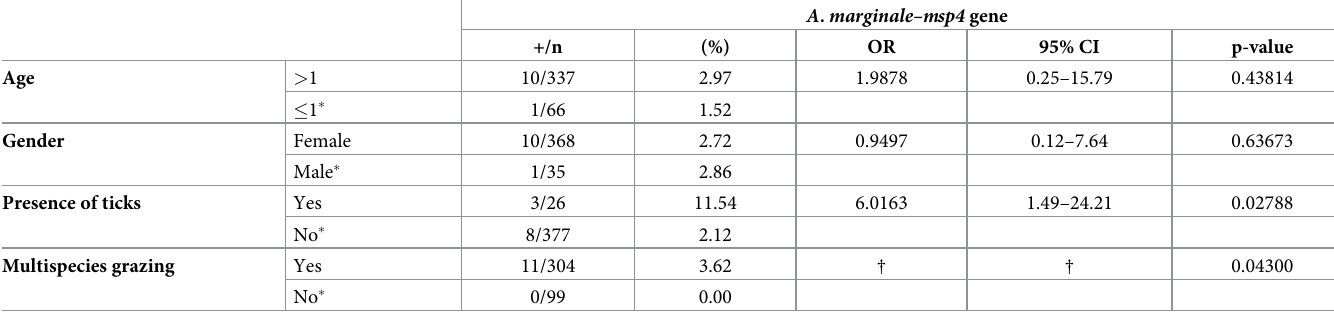
Table 1. Prevalence of Anaplasma marginale in goats within each variable studied, Paraı´ba State, northeastern